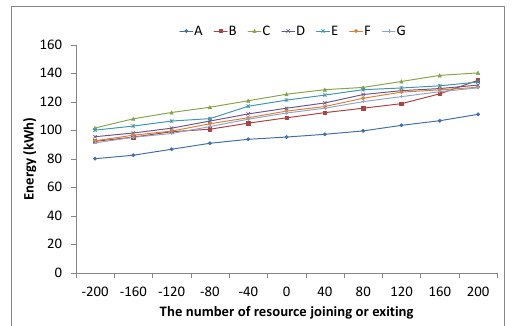
Algorithm 2 Dynamic Self-adaptive Evaluation Algorithm